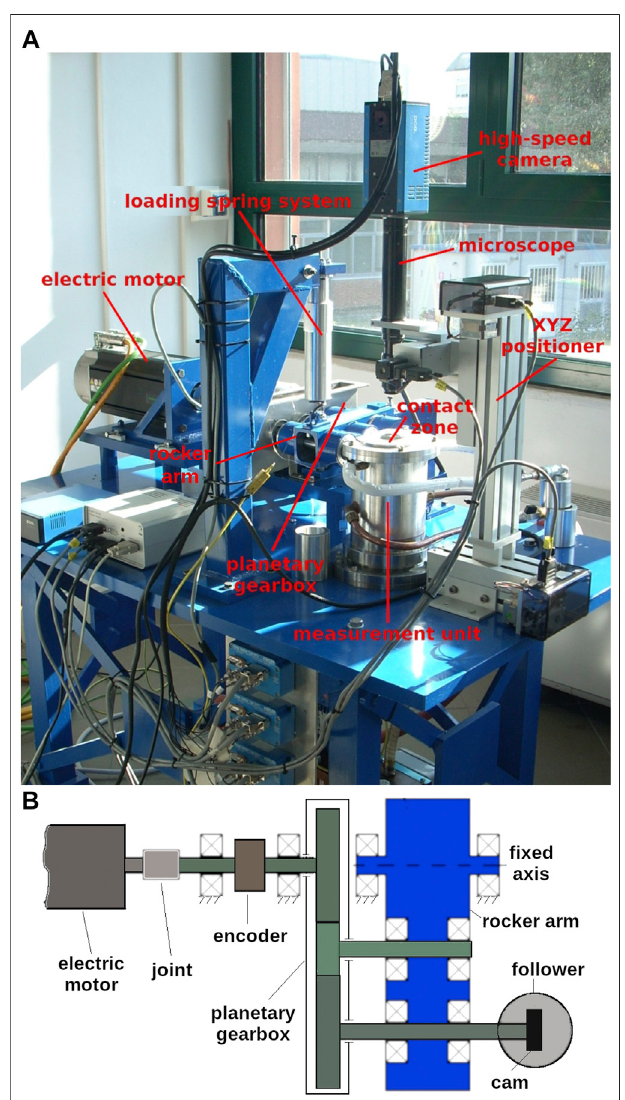
FIGURE 1 | Experimental apparatus. (A) Photograph. (B) Schematic